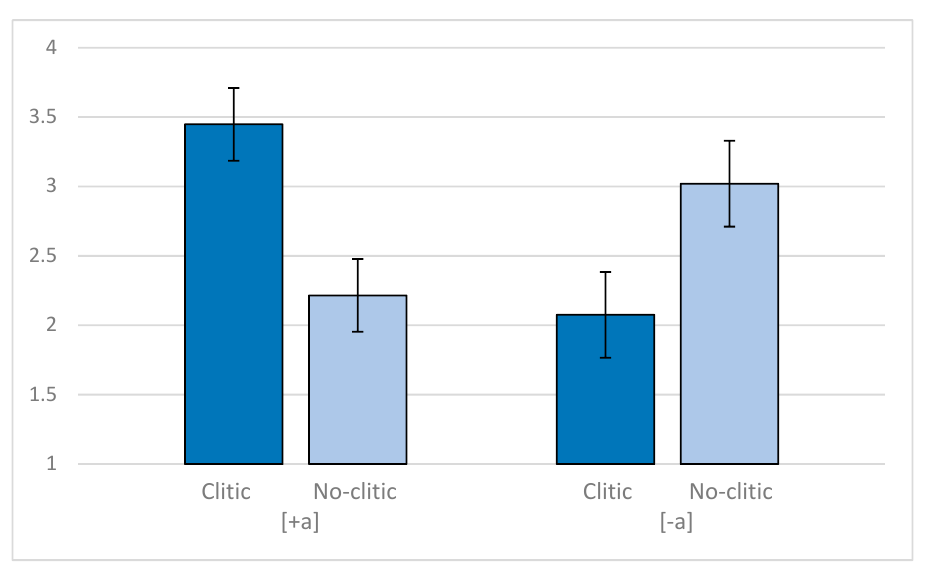
Figure 1. Baseline group ratings on the acceptability judgment task (AJT) by discourse context and clitic presence. Error bars represent 95% confidence intervals.